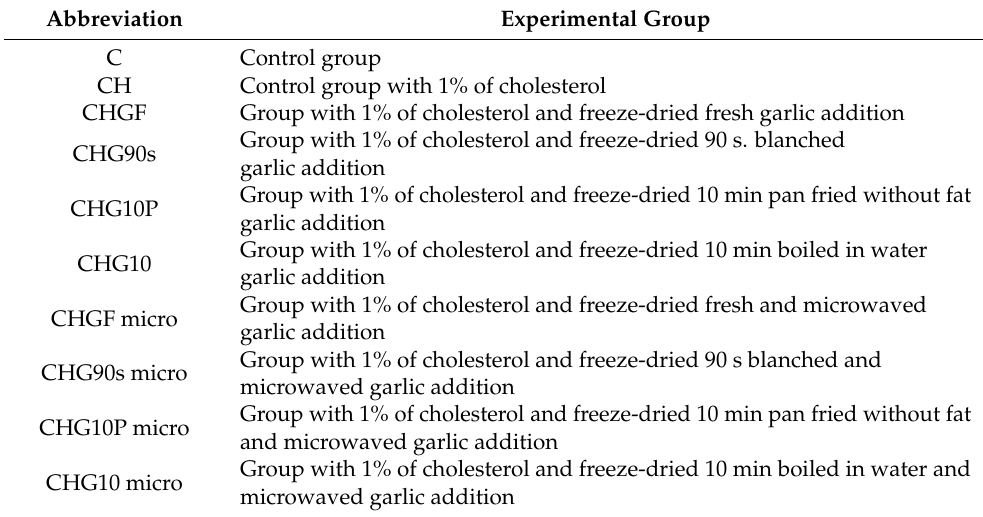
Table 2. The arrangement of the experimental